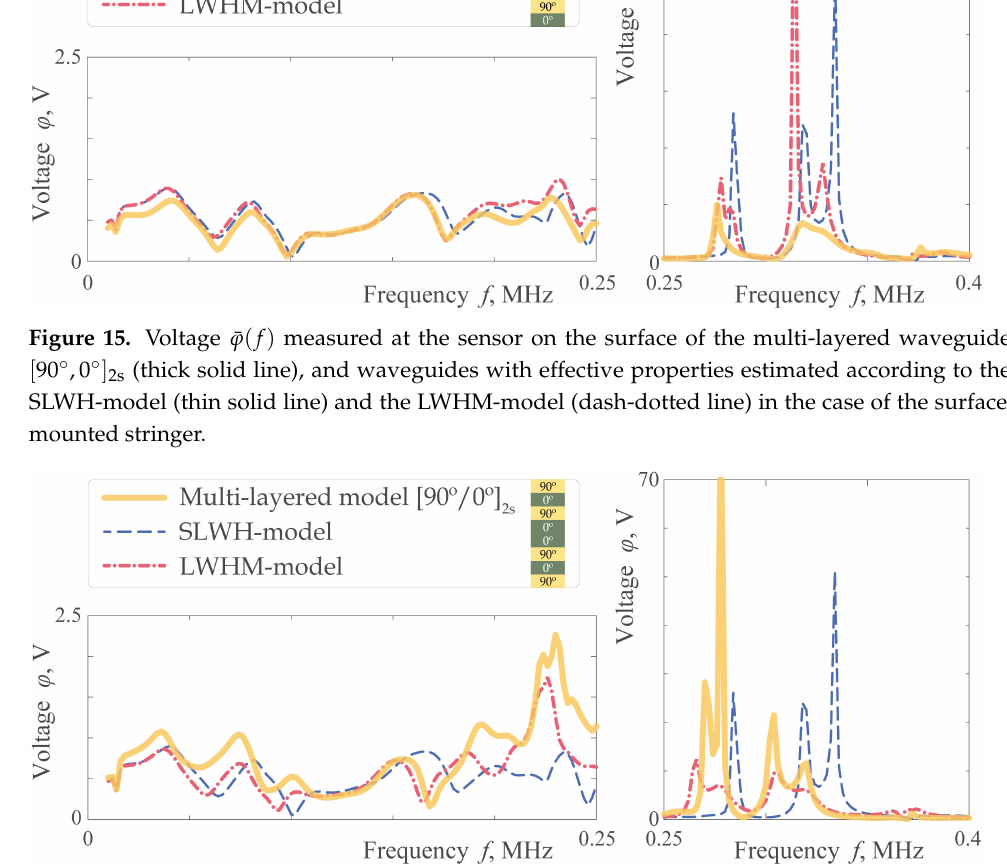
Figure 16. Voltage ¯ ϕ ( f ) measured at the sensor on the surface of the multi-layered waveguide [ 0 ◦ ,90 ◦ ] 2s (thick solid line), and waveguides with effective properties estimated according to the SLWH-model (thin solid line) and the LWHM-model (dash-dotted line) in the case of the surface- mounted